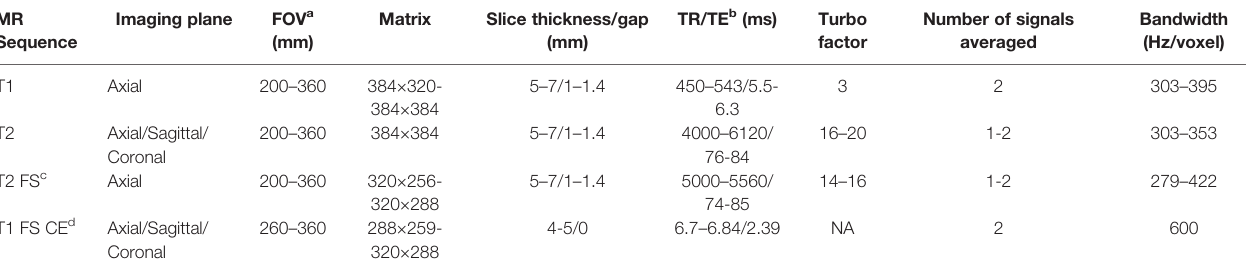
TABLE 1 | MRI parameters used in this study on a 1.5 T clinical